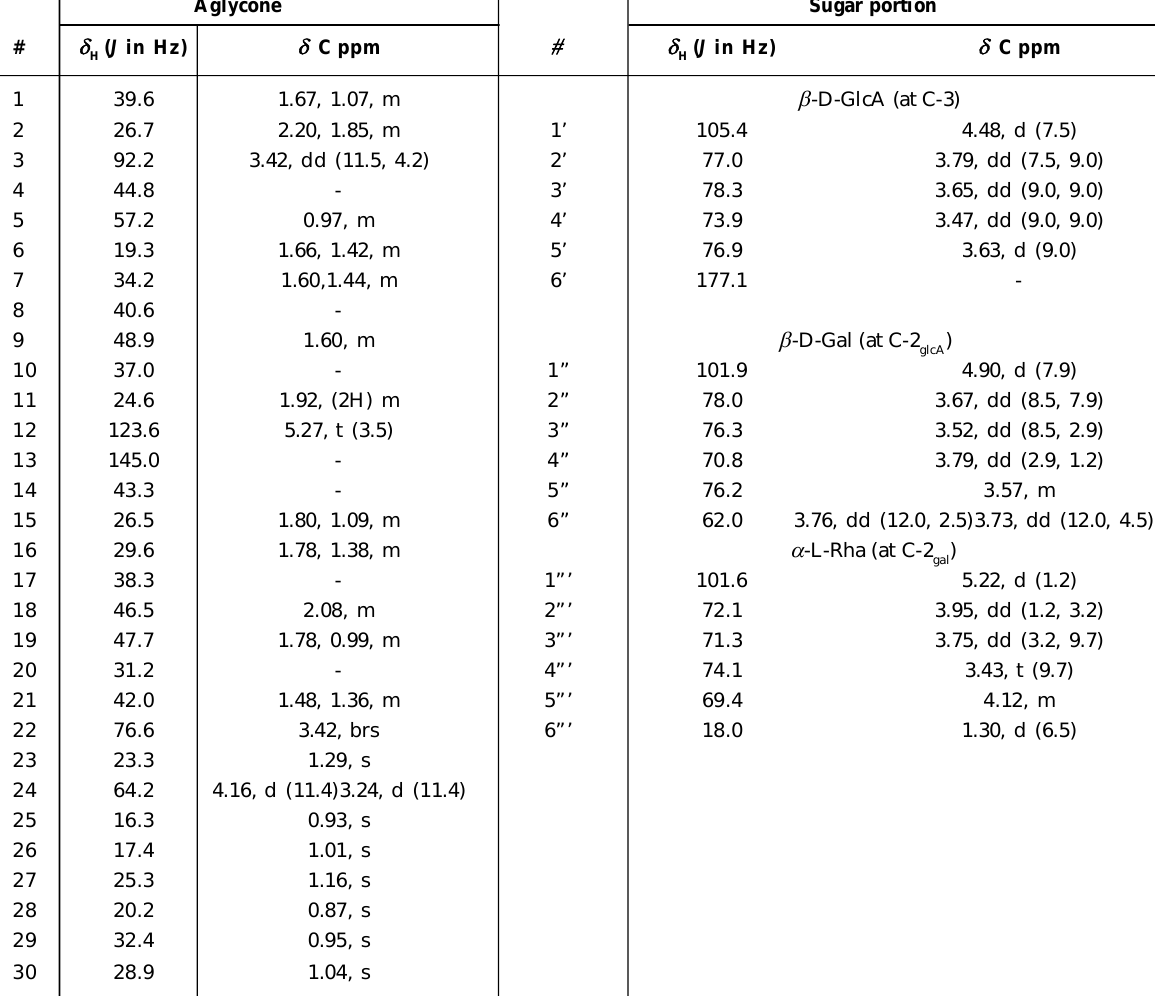
Figure 5: Positive ion mode ESI-MS spectrum of peak 1 in the n -butanol fraction of T. speciosa callus extract 1 H NMR spectrum of the compound (Table 2) revealed the presence of three sugar moieties, by the appearance of three anomeric proton doublets at  4.48( J = 7.5 Hz), 4.90 ( J = 7.9 Hz) and 5.22 ( J = 1.2 Hz) (Supplementary Data). Table 2: 1 H and 13 C NMR data of the aglycone and the sugar portion of compound I (600 Mz,  ppm, in CD Aglycone